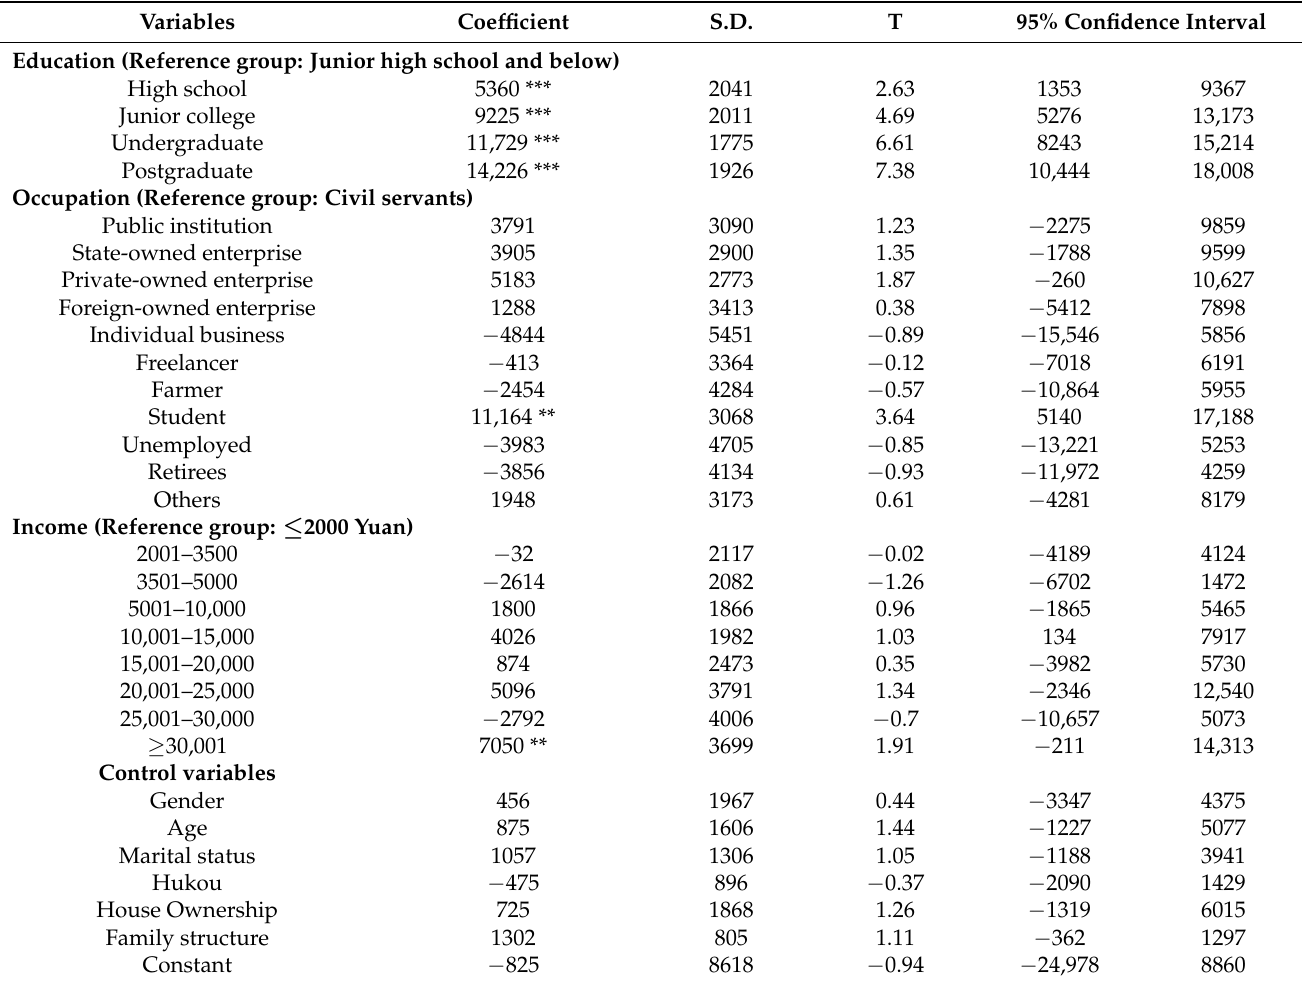
Table 7. Regression results of influencing factor